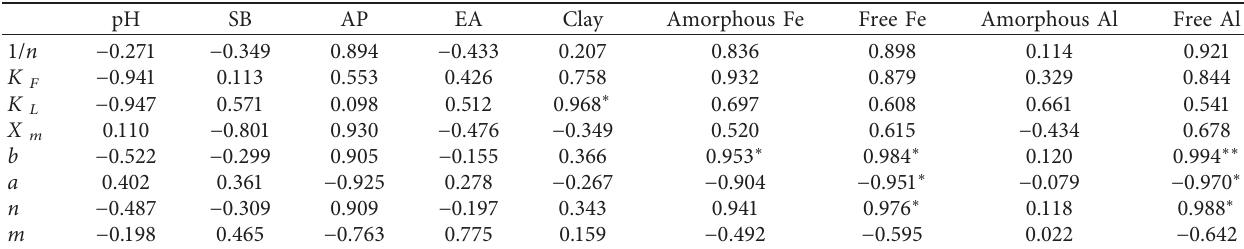
Table 4: Pearson product moment correlations between some important soil physicochemical properties and phosphorus sorption pa- rameters of the soils.